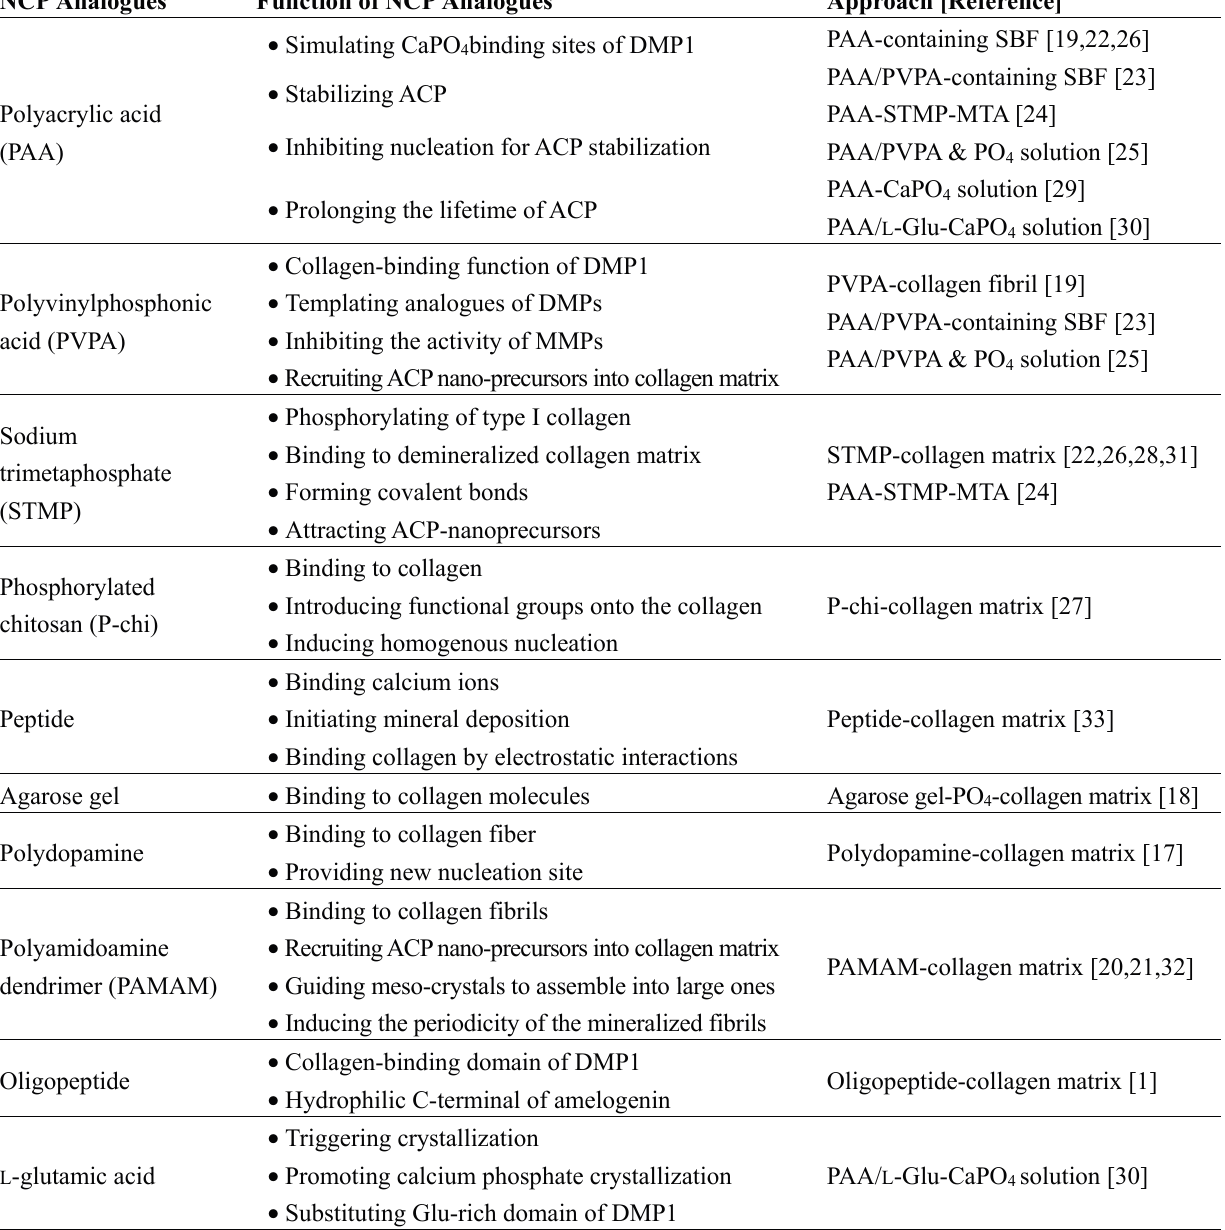
Table 2. NCP analogues and their functions in biomimetic mineralization on human dentine. NCP